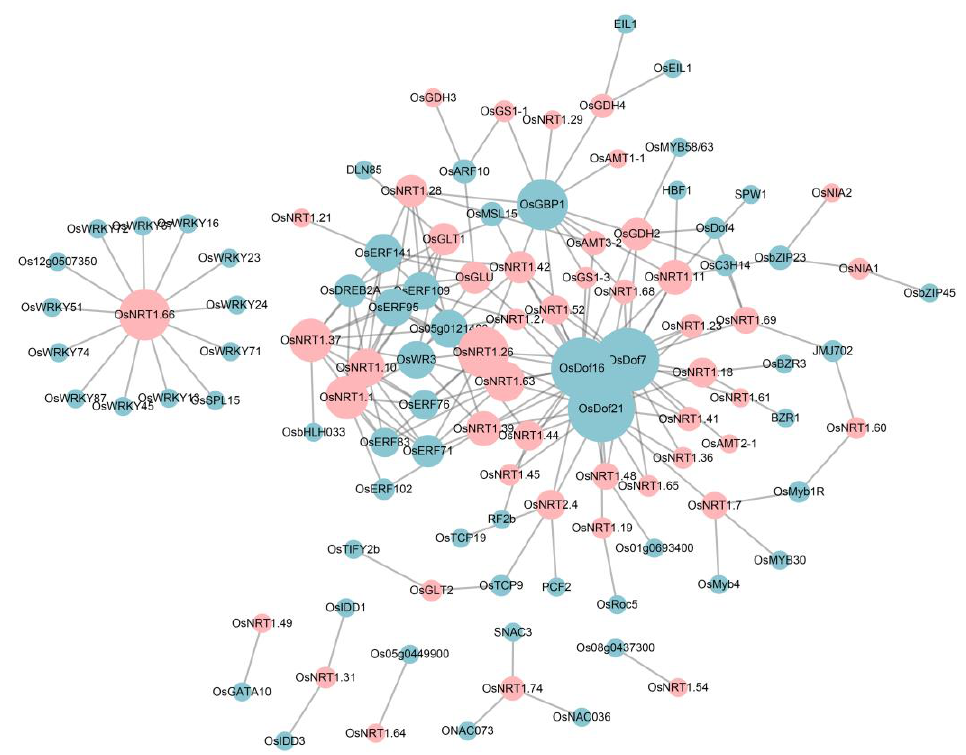
Figure 8. The co-expression regulatory network constructed by the NM gene and transcription factors (TFs). The cyan circles indicate the potential TFs which may regulate the NM genes. The pink circles indicate the NM genes which were involved in response to abiotic stress. The size of the circles represents the degree of the genes in the network.